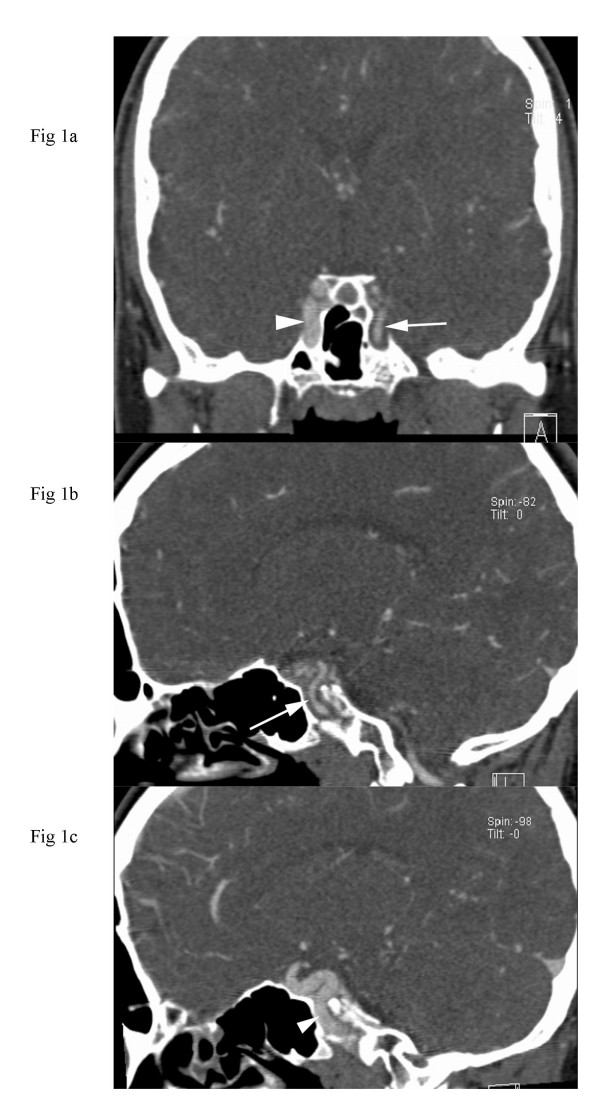
Dynamic computed tomographic scans with maximum intensity projection (MIP) images in the coronal (a) and parasagittal planes (b, c) revealing diminished caliber of the intracranial portions of the left internal carotid artery (arrow). The contralateral right internal carotid artery displays normal caliber (arrowhead).